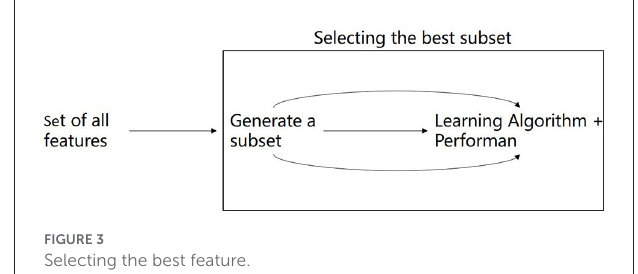
FIGURE3 Selecting the best feature.